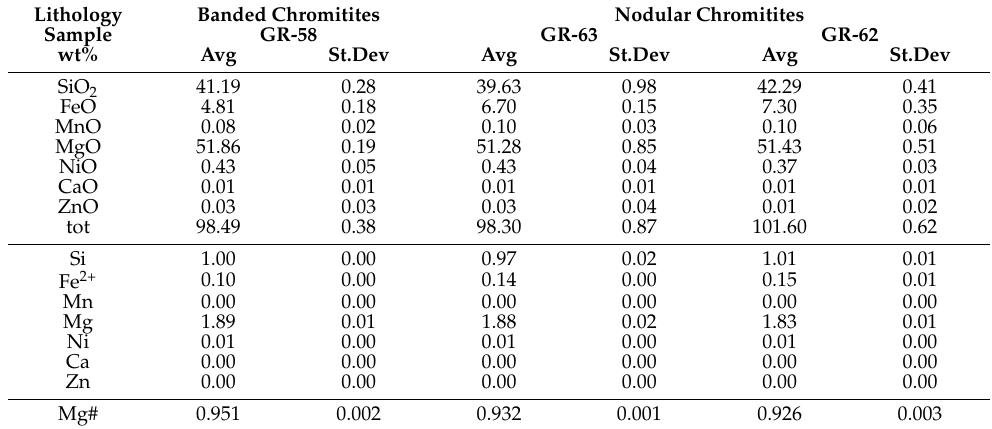
Table 4. Major and minor elements average composition and standard deviation of olivine cores from Nea Roda banded and nodular chromitites; Mg# = [Mg/(Mg + Fe 2+ )]. Banded